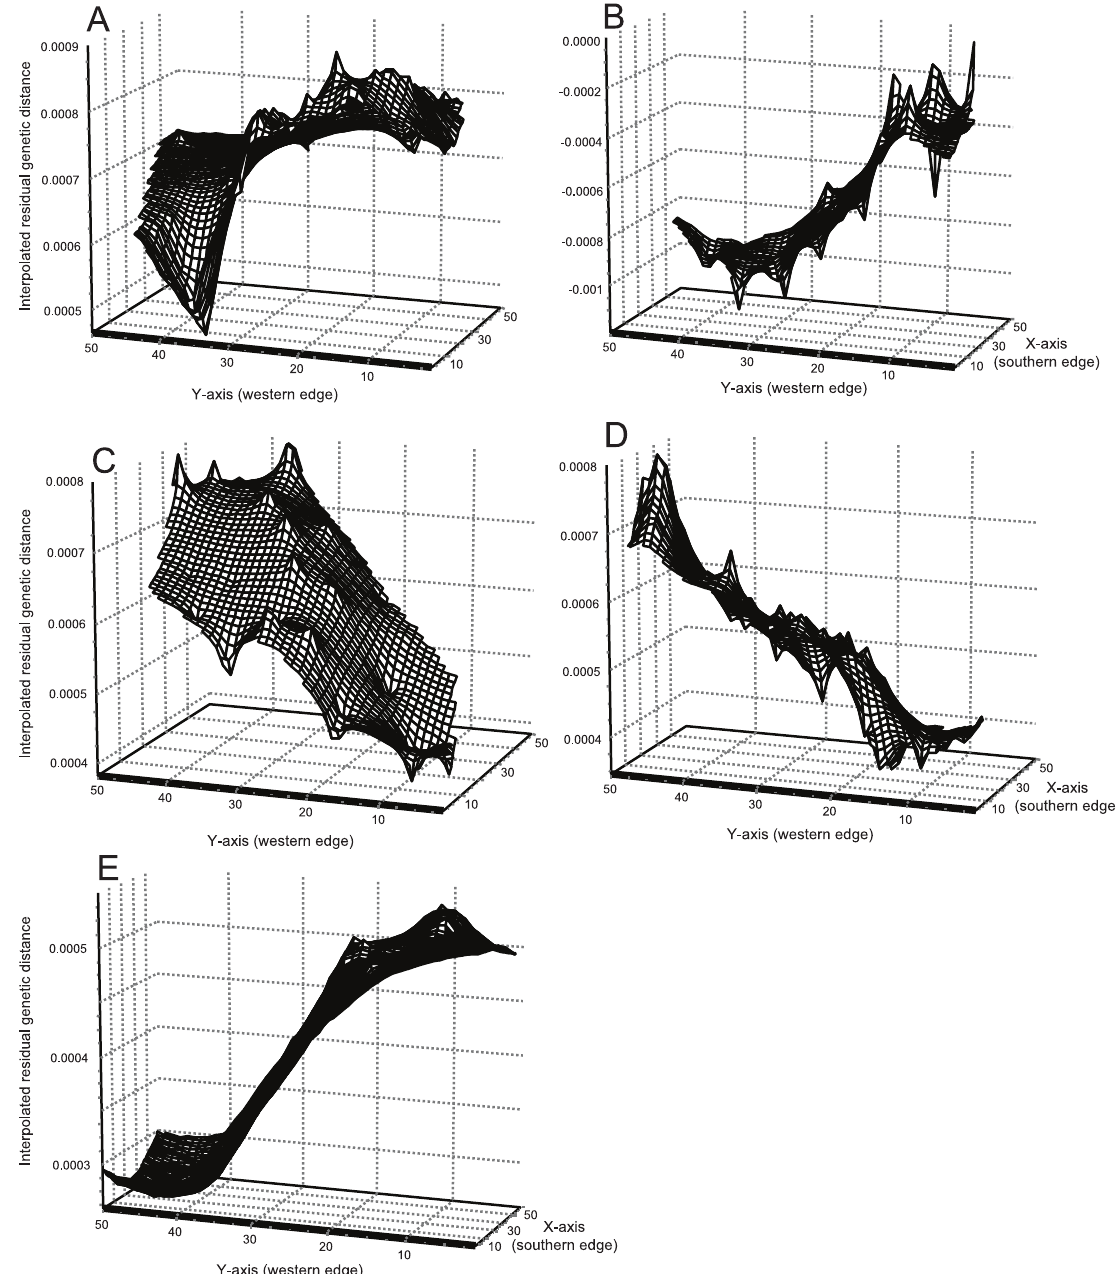
Figure 3. Results of Genetic Landscape Shape interpolations. Panel A: S. o. caurina , Panel B: P. monticola , Panel C: A. longicaudus , Panel D: R. variegates , Panel E: a randomly selected simulated data set using d =1.5 and m =10 2 4 during simulation runs. Surface plot heights reflect genetic distance (and genetic diversity) patterns over the geographical landscape examined.